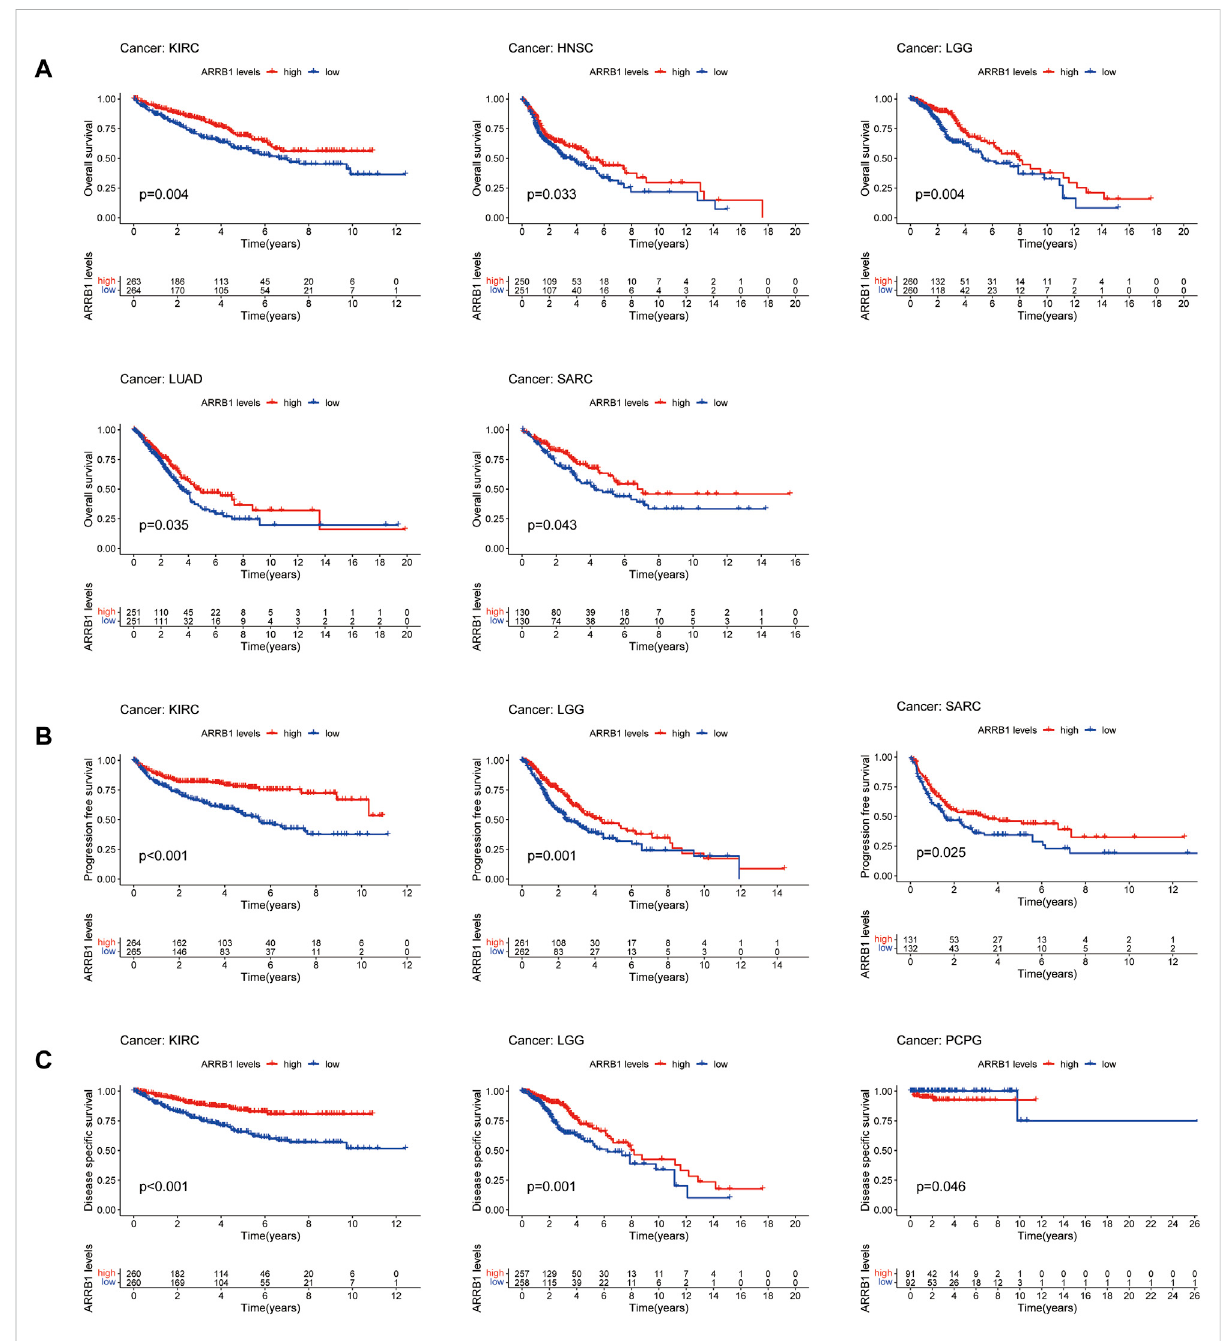
FIGURE 4 Associations of ARRB1 expression with survival among cancer patients. Kaplan-Meier survival curves showing (A) OS, (B) PFS, and (C) DSS in pan-cancer. Only signi fi cant outcomes were displayed ( p < 0.05).